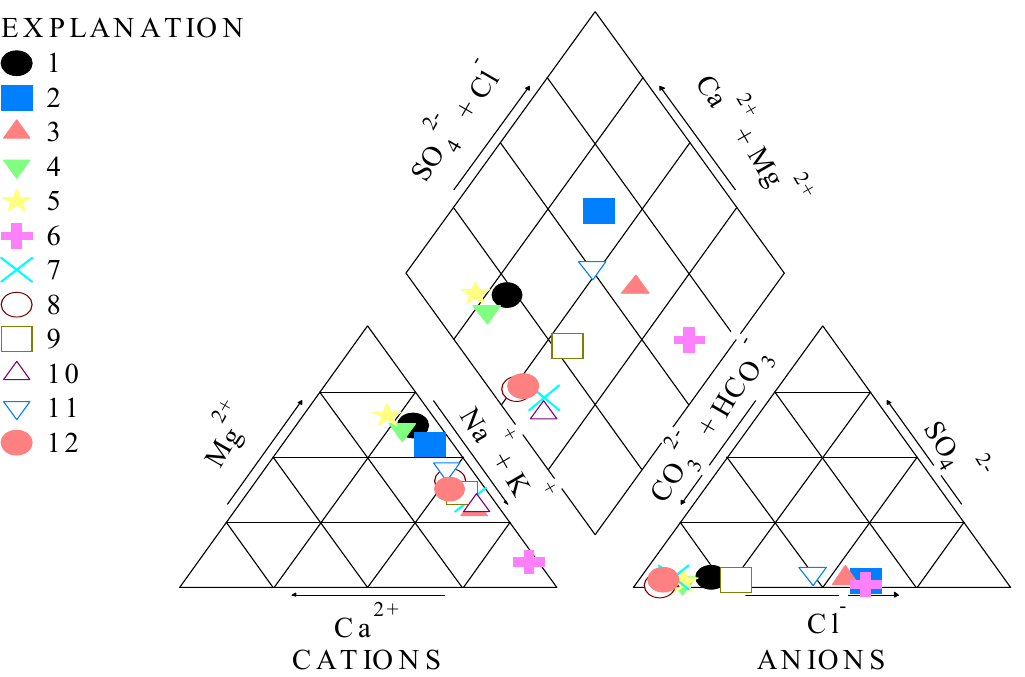
Figure 2. Piper trilinear diagram for the water samples (1–12).